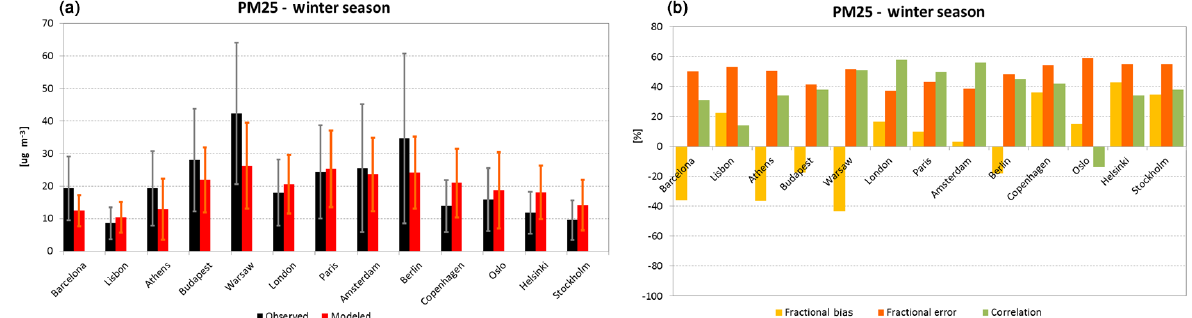
Figure 6. Evaluation of CAMx model performance for PM 2 . 5 at selected cities from 1 January to 31 March 2010. (a) Comparison of the observed (black) and modeled (red) seasonal mean concentrations. Bars show the corresponding observed (grey) and modeled (orange) standard deviation. (b) The seasonal fractional bias (orange), fractional error (red), and correlation (green) computed for each